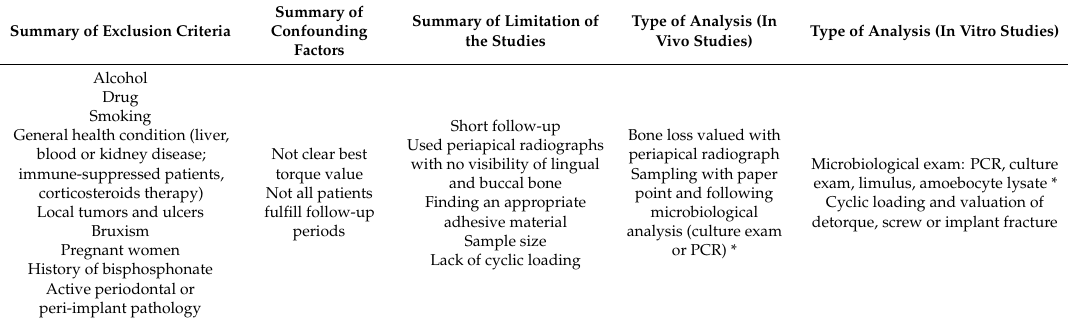
Table 3. Exclusion criteria, confounding factors and limitations of the included